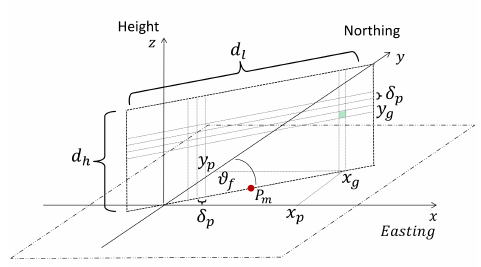
Figure 4. Design of vertical focusing plane in CSAR geometry. Input parameters are P m and orientation ϑ f .